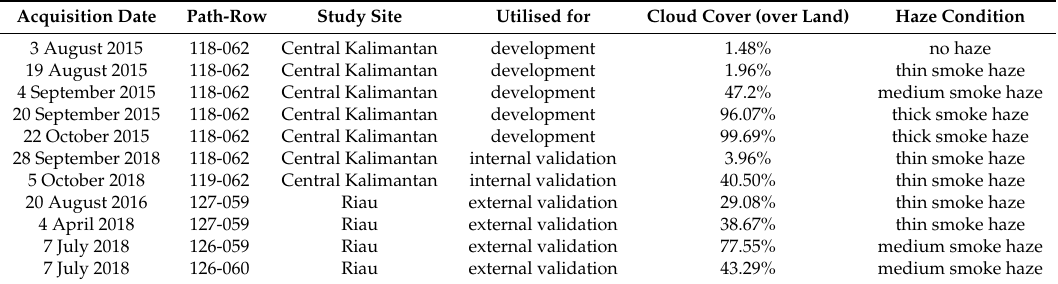
Table 1. List of Landsat-8 data used for algorithm development and validation. The algorithm development area was in Central Kalimantan using 2015 data, while validation analysis was conducted in Central Kalimantan (2018) and Riau Provinces (2016 and